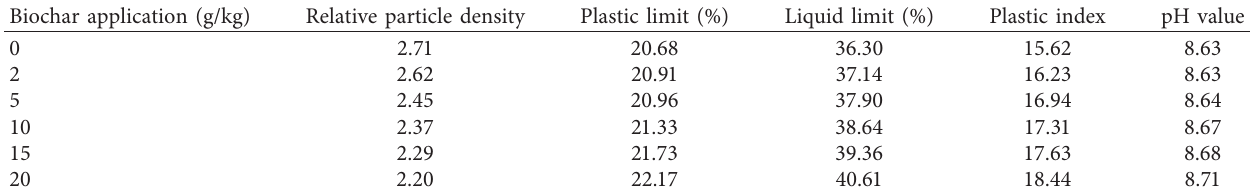
Table 2: Effect of biochar content on physical and chemical properties of soil.